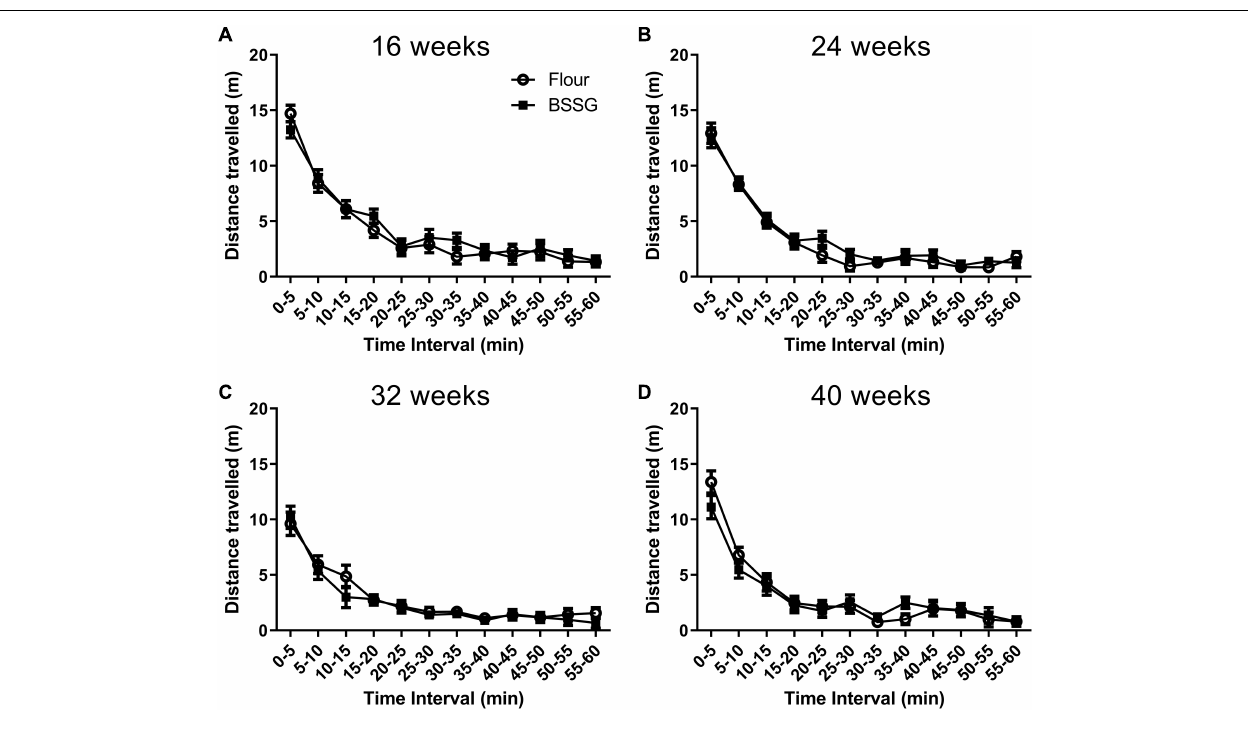
FIGURE 3 | Distance travelled in the open field in 5 min intervals. (A) 16 weeks; (B) 24 weeks; (C) 32 weeks; (D) 40 weeks. Data are shown as means ± SEM, n = 8–10.